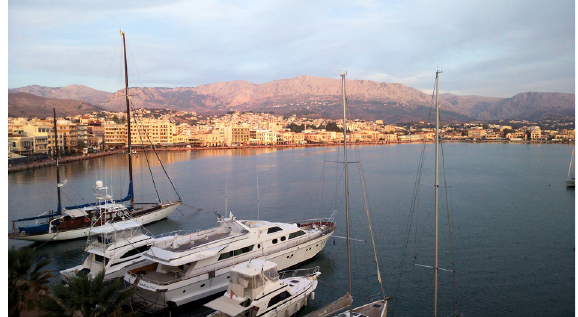
Fig. 4. Chios Island, Greece. The city of Chios (Photo: T.S. Terkenli).